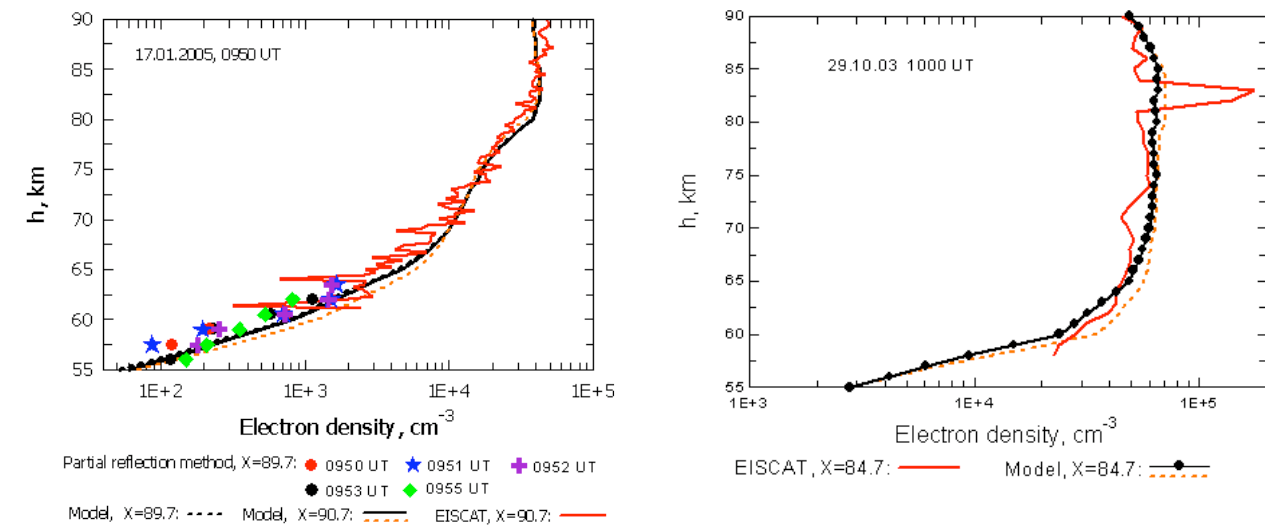
Fig. 5a. Electron density profiles measured (red solid curve and symbols) and calculated for the SPE on 17 January 2005 at 09:50UT for zenith angles 89.7 ◦ and 90.7 ◦ using the O, O 3 and NO profiles 4–6 in Fig. 1 (black curve) and using the O, O 3 and NO-profiles 1–3 in Fig. 1 (red dashed curve).